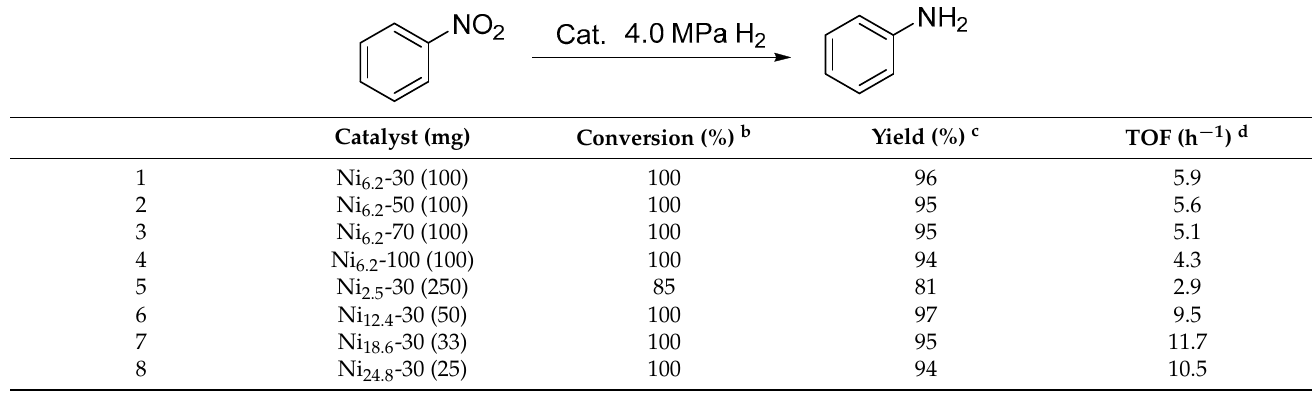
Table 2. Reduction of nitrobenzene by different catalysts a .